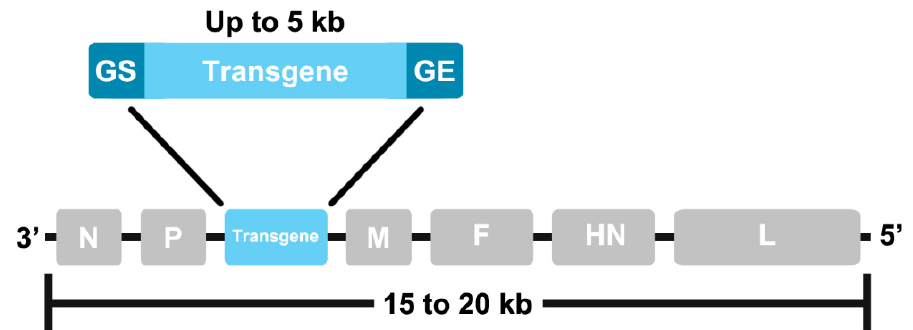
Figure 1. A representation of the NDV single-stranded negative-sense RNA genome including the six native transcriptional units. Transgenes are typically inserted between the P and M genes and flanked by NDV gene start (GS) and gene end (GE) sequences. The total genome length must be an even multiple of six (“rule of six”) to ensure complete encapsidation.